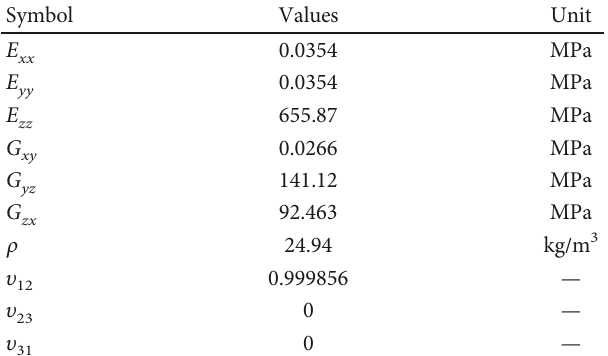
Figure 14: Substructure division of CMG on the rigid